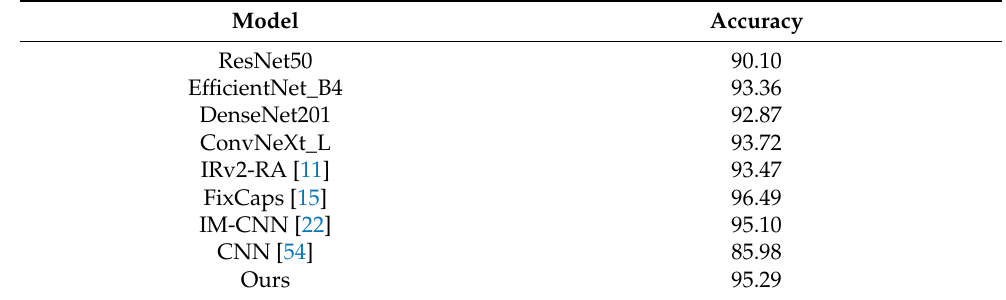
Table 5. The accuracy of each model on the public dataset HAM10000 (test set of 828 images); the unit is